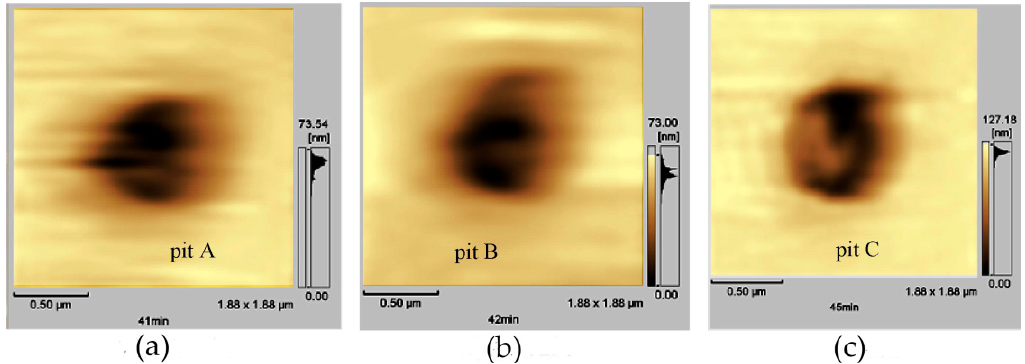
Figure 12. AFM images of solution-treated SUS304 stainless steel during corrosion in 3.5 wt% sodium chloride solution at 298 K (I = 10 A/m 2 ): ( a ) t = 2.46 ks; ( b ) t = 2.52 ks; ( c ) t = 2.7 ks. Reprinted with permission from Reference [48]; copyright 2005 Elsevier Ltd.